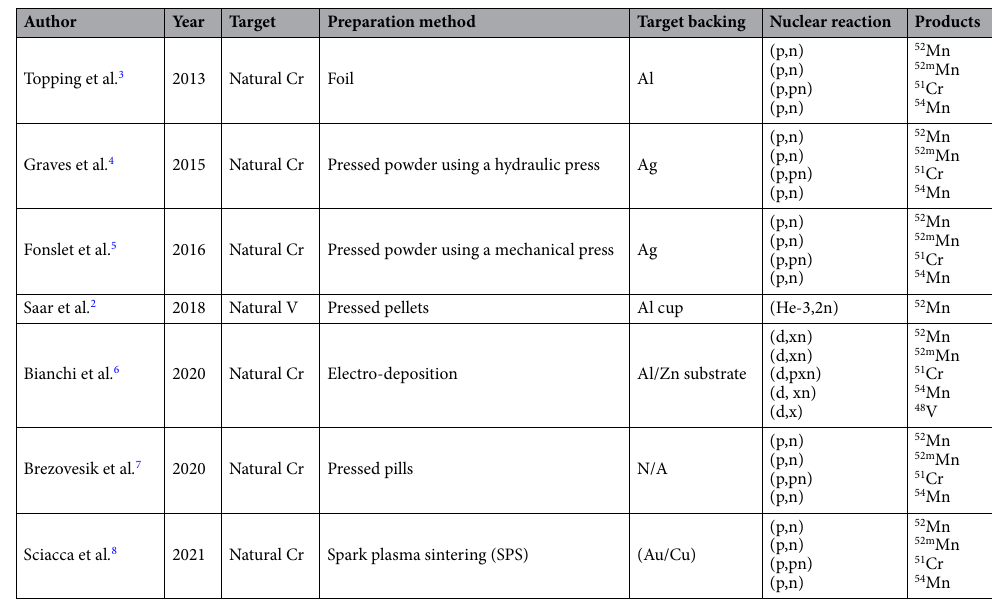
Table 1. Prior natural Cr and V target configurations.